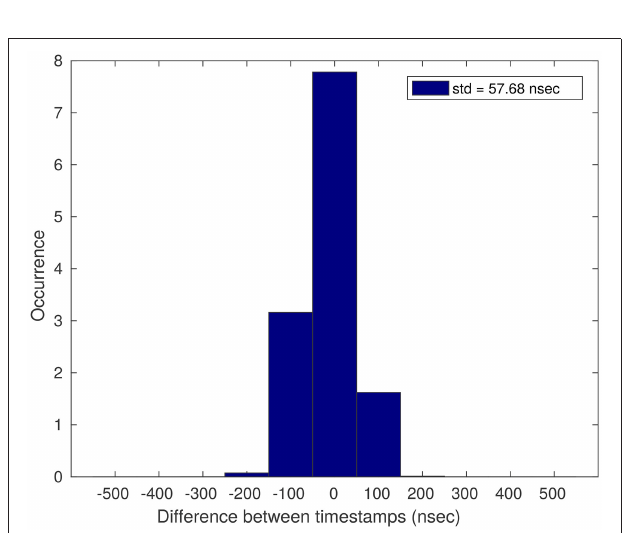
FIGURE 16 | Laboratory floor structure.